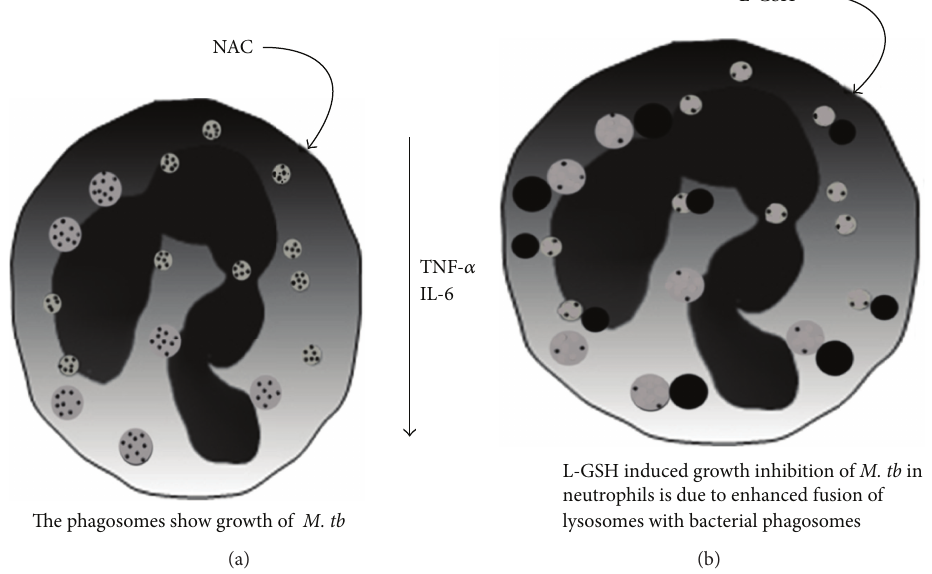
Figure6:Modelillustratingtheunderlyingmechanismsthatareresponsibleforgrowthof M.tb inNAC-treatedneutrophils(a)andinhibition in the growth of M. tb in L-GSH-treated neutrophils